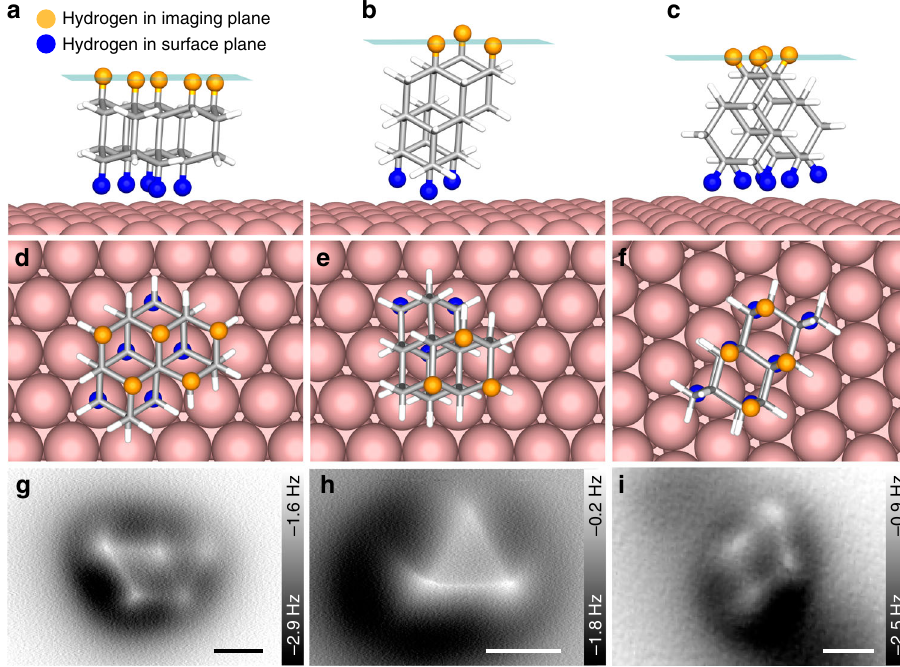
Fig. 3 Three different orientations of ( M )-[123]tetramantane. In the fi rst two rows side ( a – c ) and top views ( d – f ) of the corresponding computed orientations are depicted. The planes in the fi rst row indicate the imaging plane of the corresponding AFM scans (shown in the third row, g – i ). Hydrogen atoms in the imaging and surface planes are marked in orange and blue, respectively. Each orientation results in a characteristic pattern of hydrogen atoms within the imaging plane, which resemble the shape of the Olympic rings ( d , g ), a triangle ( e , h ), and a rhombus ( f , i ). Scale bars: 0.3